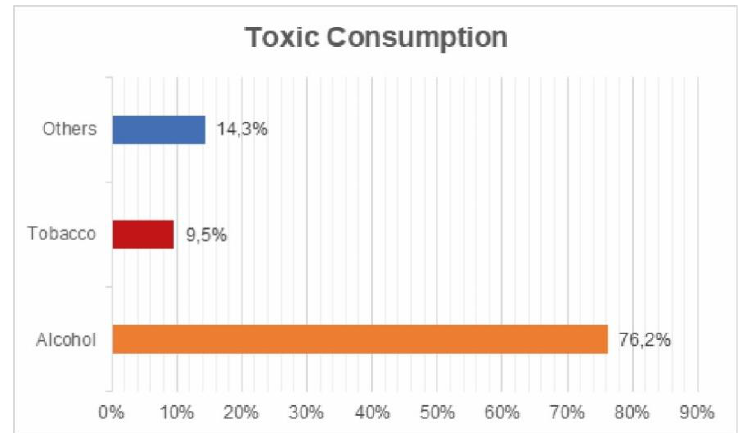
Figure 10. Toxic substances survey.